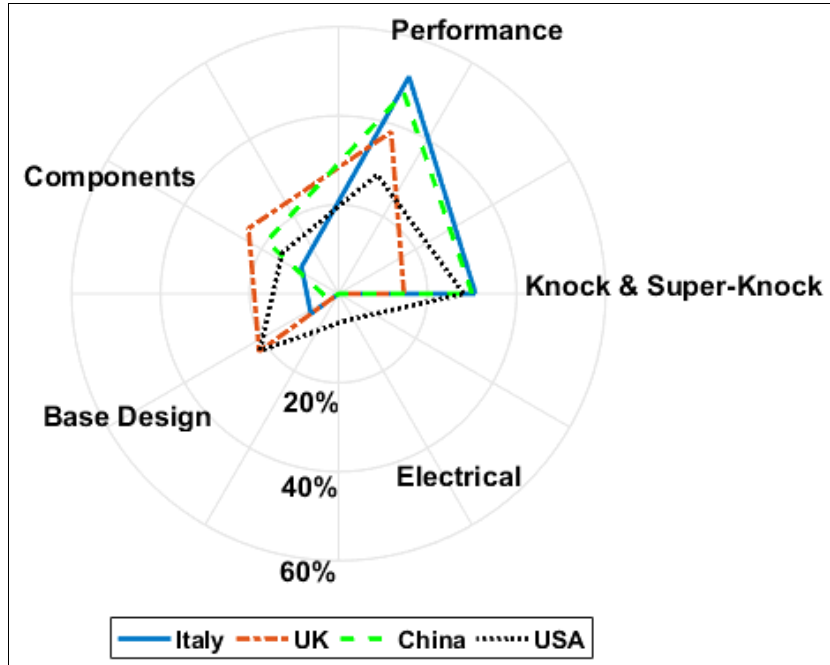
Figure 5. Research distributions of top countries on engine